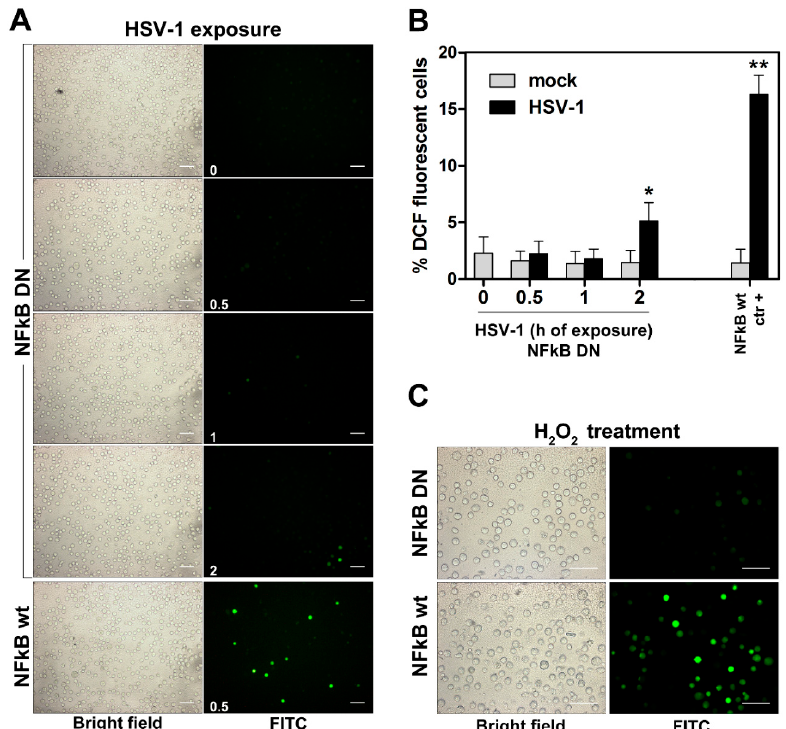
Figure 2. Effects of NF-kB ablation on ROS production in U937 cells. DCFH-DA preloaded U937-DN-IkB (NFkB DN) were exposed to HSV-1 (MOI = 50 PFU/cell) or vehicle alone (mock) from 0.5 to 2 h for ROS detection by fluorescence microscopy. In each experiment, DCFH-DA preloaded wt U937 cells (NFkB wt), exposed or mock exposed to HSV-1 for 0.5 h, were also included as positive controls. ( A ) Representative images by 20 × objective. Times of HSV-1 exposure (h) are reported in the FITC frames (0 = mock infected U937-DN-IkB). Scale bar = 50 µ m. ( B ) % of DCF fluorescence positive cells (mean + S.D.) from 8 frames randomly selected from two independent experiments (4 frames each). * p < 0.01, ** p < 0.001 vs. control (h = 0). ( C ) DCFH-DA preloaded NFkB DN or wt U937 cells, were treated with 5 µ M H 2 O 2 for a further 30 min and then washed and analysed for ROS production by fluorescence microscopy. Objective 40 × , scale bar = 50 µ